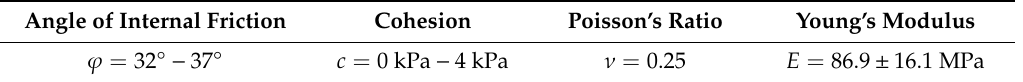
Table 1. Physical parameters (elastic-plastic model) of regenerated sand. Angle of Internal